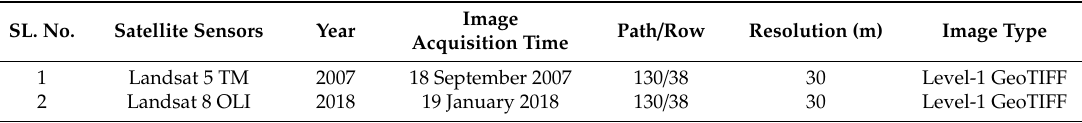
Table 1. Details of data used in the present study.